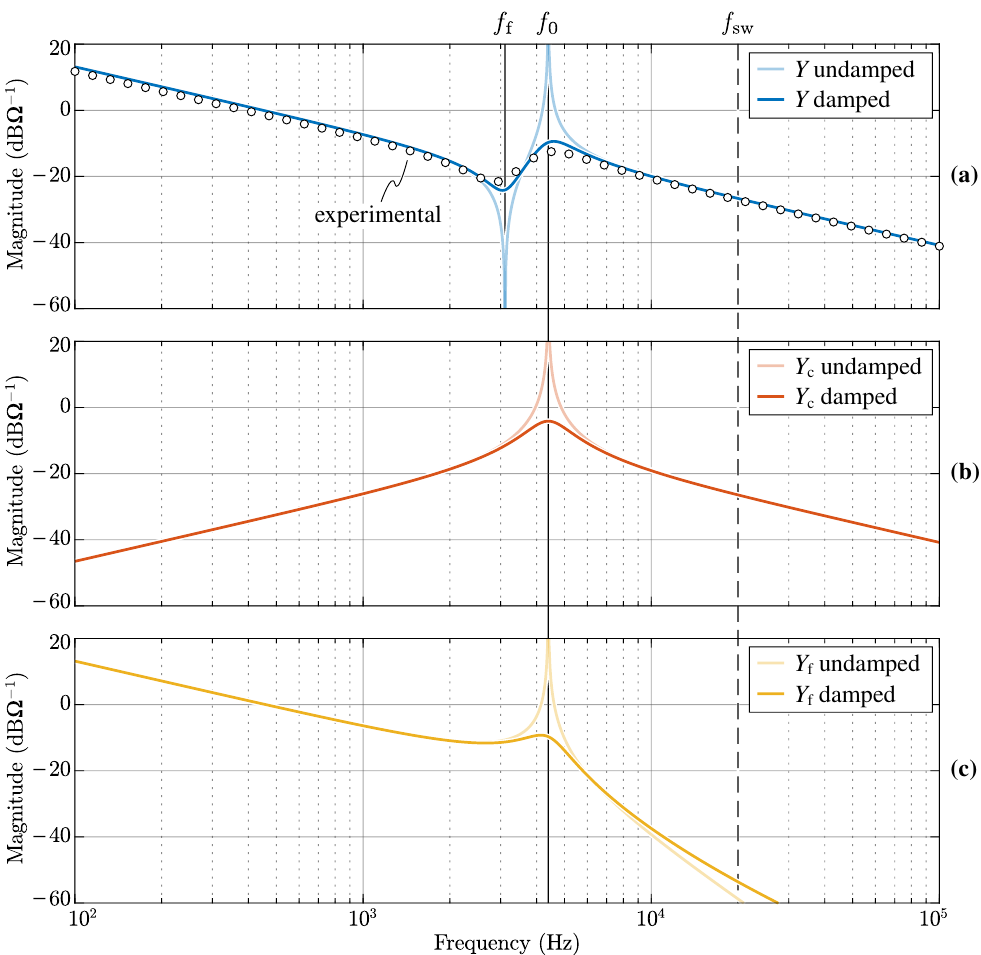
Figure 15. Analytical LCL filter transfer functions ( a ) Y , ( b ) Y c and ( c ) Y f , with and without passive damping (i.e., R f = 0.8 Ω in the damped case). The value of Y measured experimentally is reported for comparison purposes in ( a